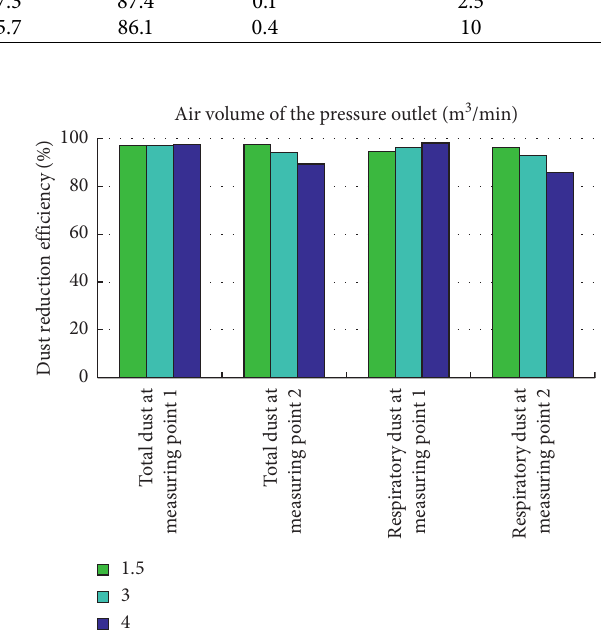
Figure 18: Dust-reduction efficiency at measuring points 1 and